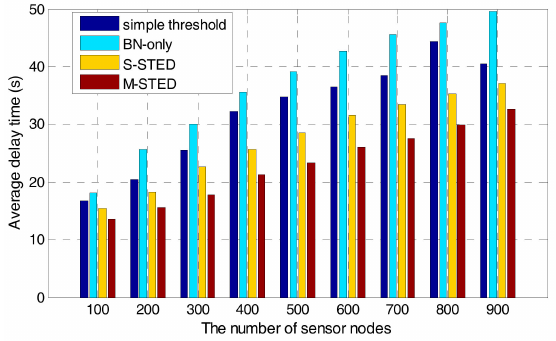
Figure 12. The average delay time in the different node